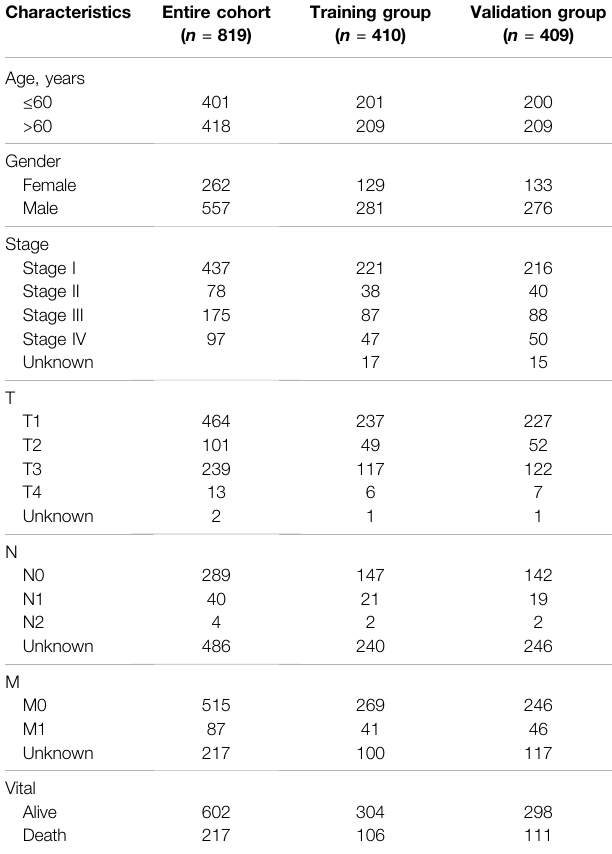
TABLE 1 | Characteristics of renal cancer patients.